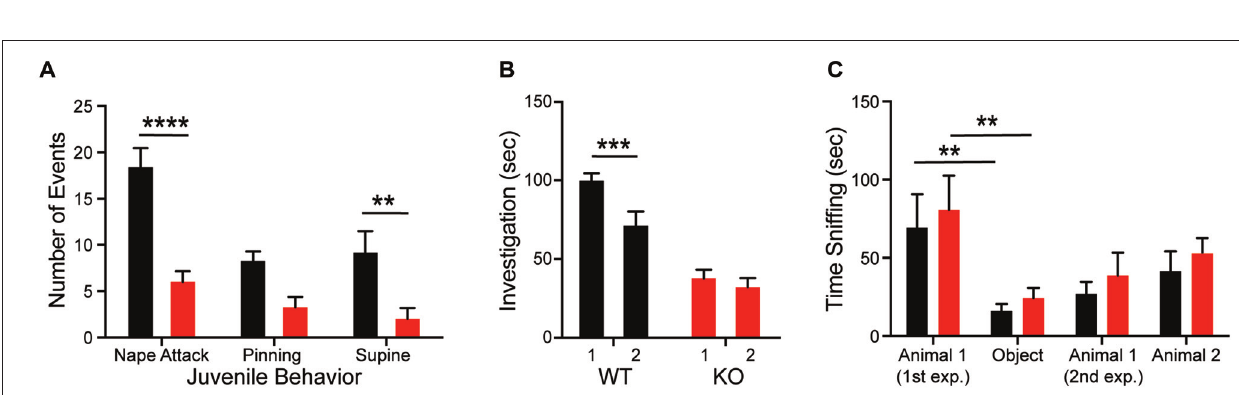
measured by time with nose in proximity to the stimulus cup, similar to WT animals ( Figure 2C ; stimulus : F ( 3,54 ) = 10.2, p < 0.0001). While both groups also show a preference for the